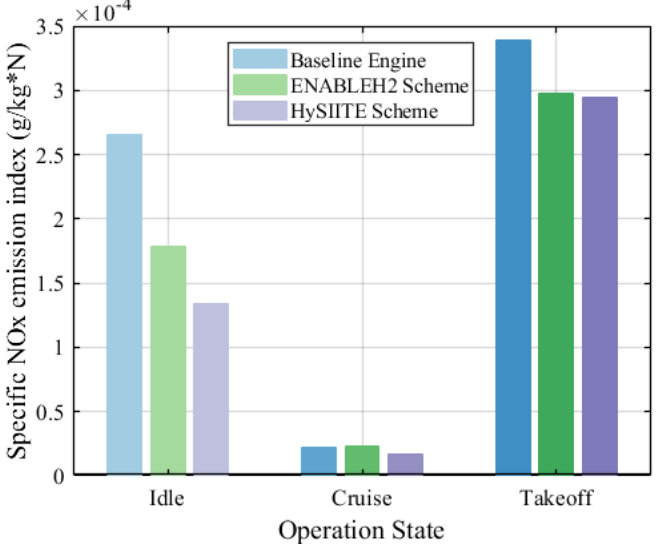
Figure 10. NOx emission comparison of the baseline engine, ENABLEH2 scheme, and HySIITE scheme at different operating points.